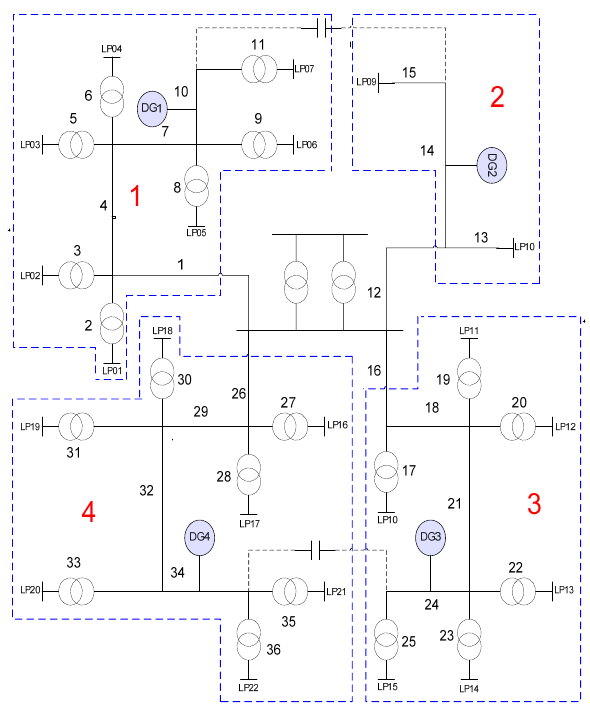
Figure 2. RBTS 2BUS